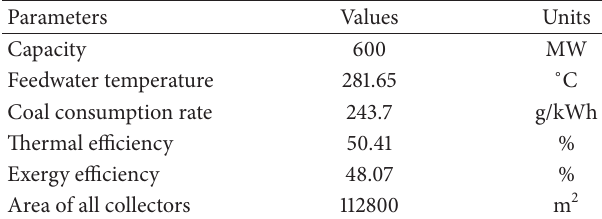
Table 3: Main designed parameters of solar aided power plant.